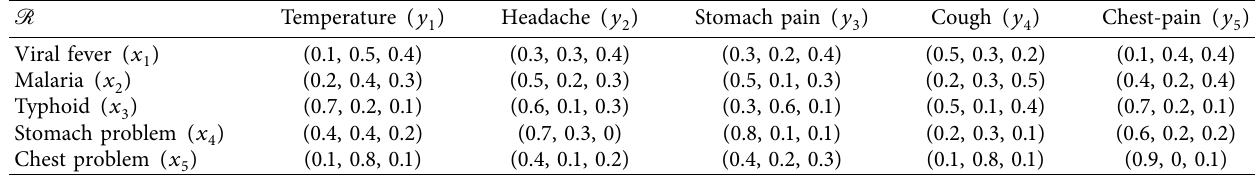
Table 4: Picture fuzzy relation R ∈ I U × V between the diseases and